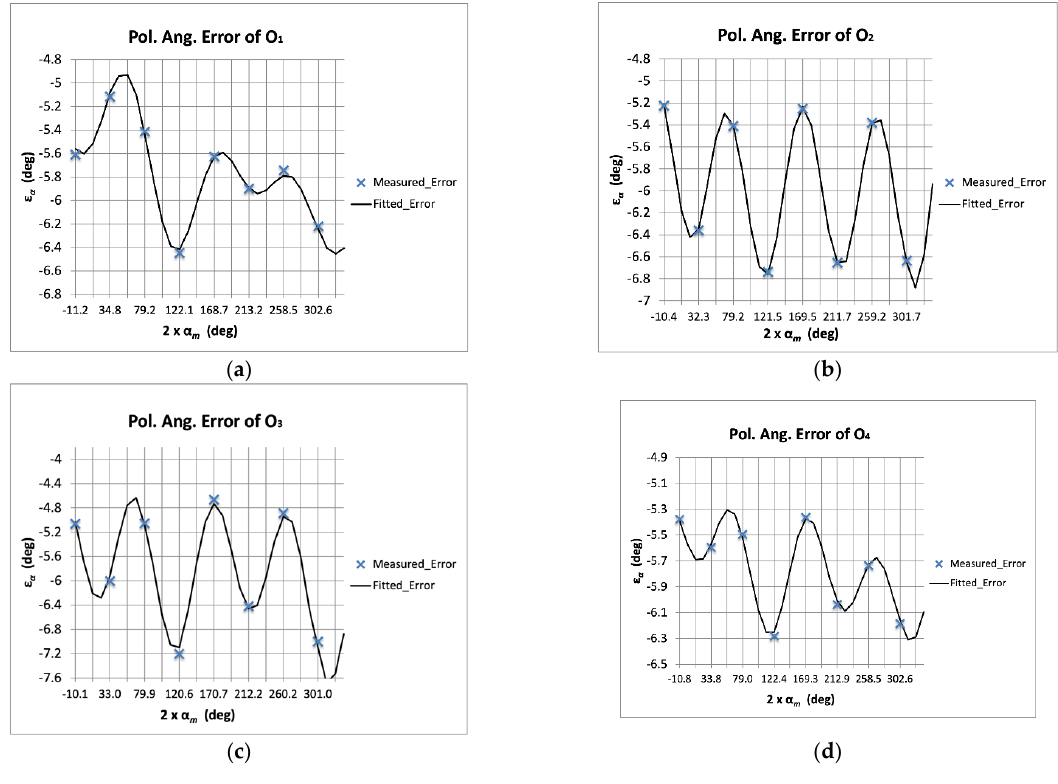
Figure 3. Measured polarization angle errors ( ε αm , blue crosses) superposed to the fitted ones ( ε αf , black line) with five additive terms, given as a function of the measured polarization angles ( α m ) and for each one of the polarimeter outputs: O 1 ( a ), O 2 ( b ), O 3 ( c ), and O 4 ( d ).